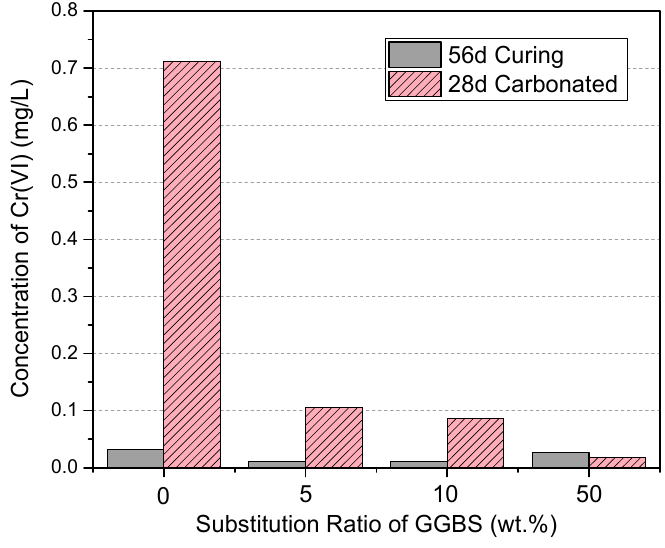
Figure 10. Tank leaching test results for the GGBS-PC paste before and after an accelerated carbonation test.